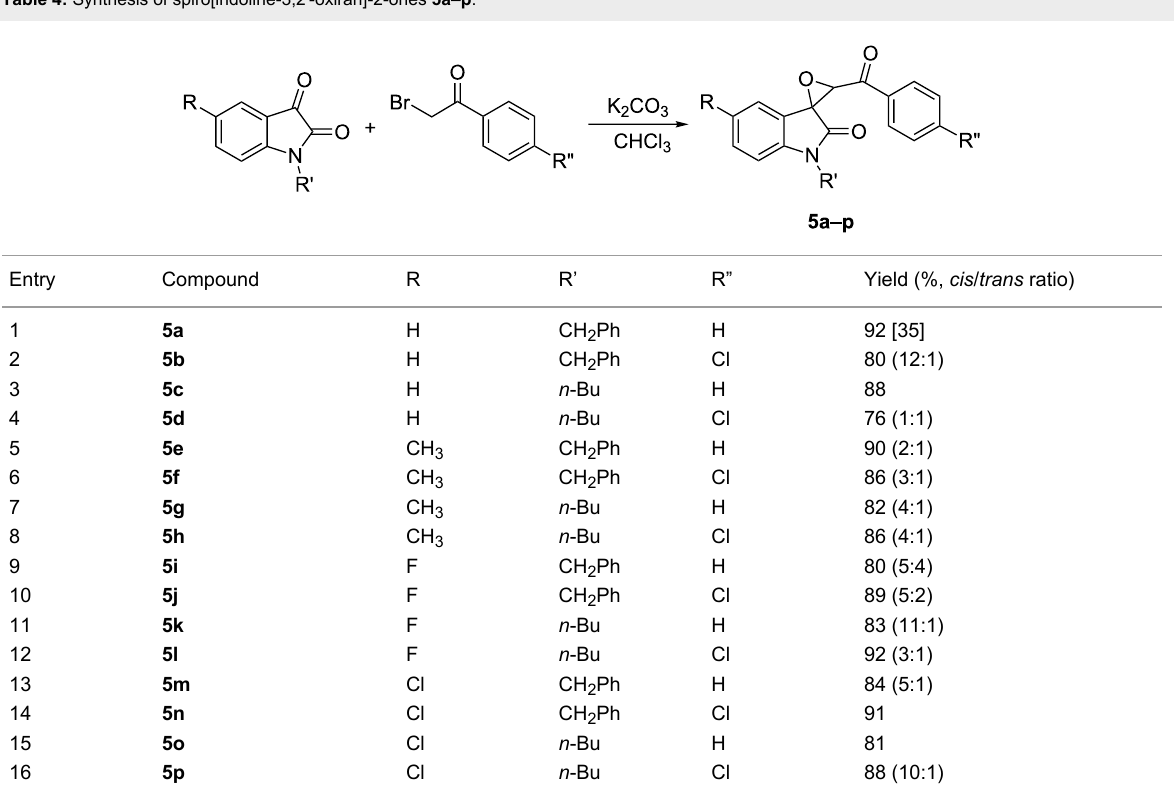
Table 4: Synthesis of spiro[indoline-3,2'-oxiran]-2-ones 5a – p .